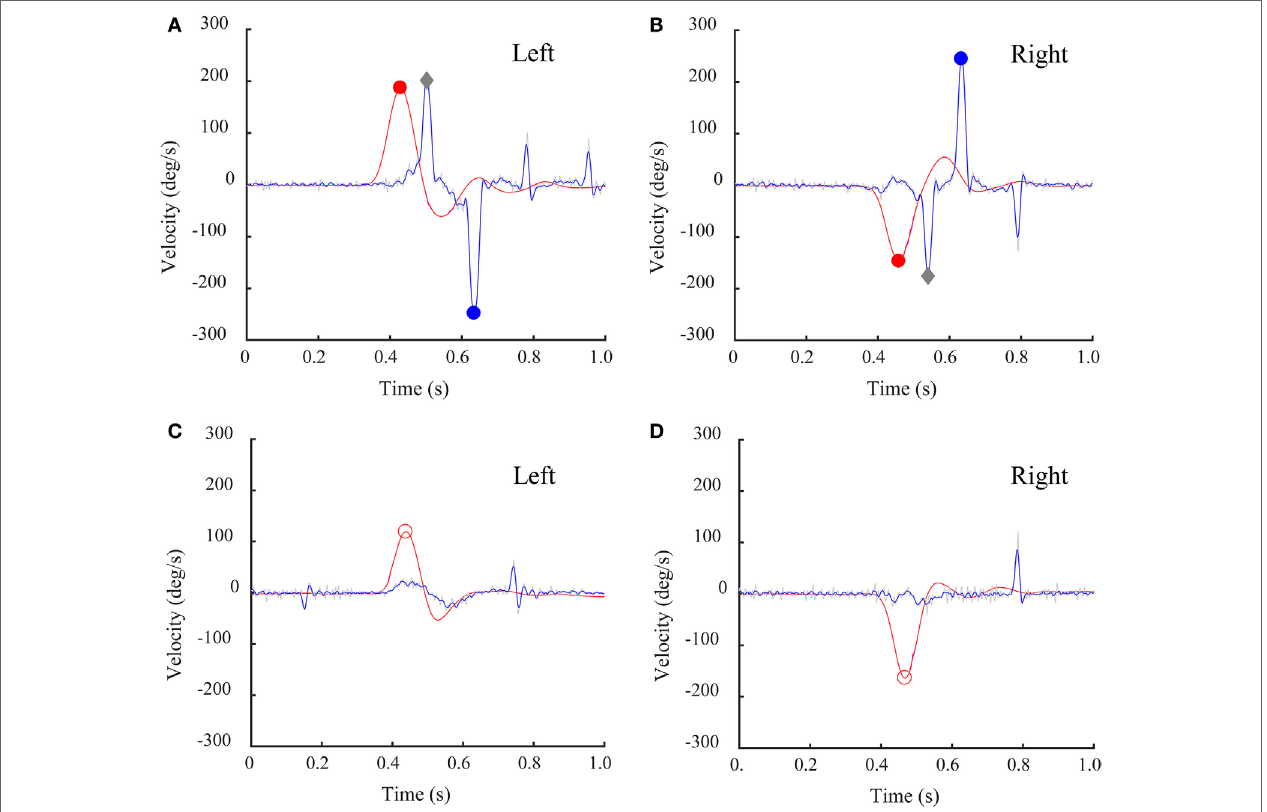
FigUre 5 | Individual time series records of a bilateral vestibular loss (BVL) patient’s SHIMP results with a covert saccade and corresponding SHIMP anti- compensatory saccades. Eye velocity has been inverted to facilitate comparison with head velocity. (a,B) This BVL patient, with low head impulse test (HIMP) gain, made a covert saccade followed by a large anti-compensatory saccade for both left (a) and right (B) rotation. Gray diamonds: peak saccade velocity of covert saccades. (c,D) This BVL patient with low HIMP gain did not make a covert saccade and did not make a corresponding anti-compensatory saccade for head turns to either side. Red circles: peak head velocity; blue circles: peak saccade